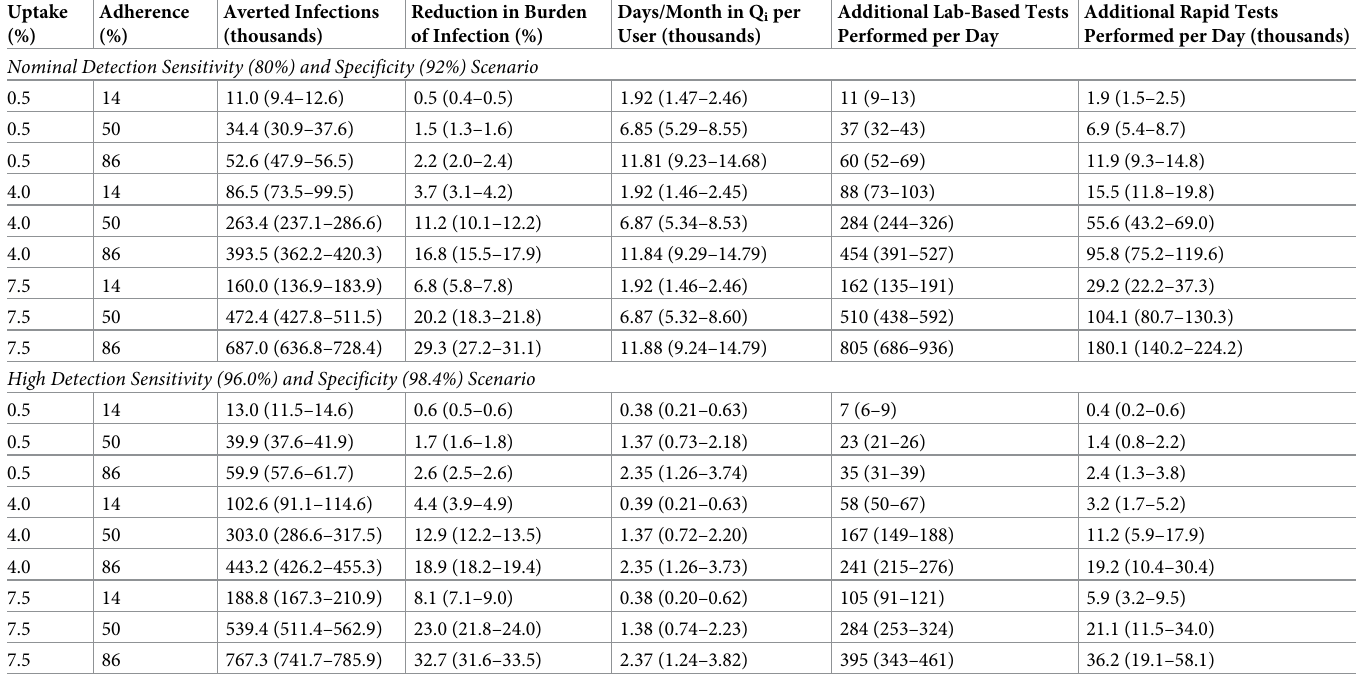
Table 1. Impact of offering confirmatory rapid antigen tests under different technology and behavioural assumptions. 95% confidence intervals are listed in paren- theses. Table E in S1 Text depicts outcomes in analogous scenarios without rapid antigen